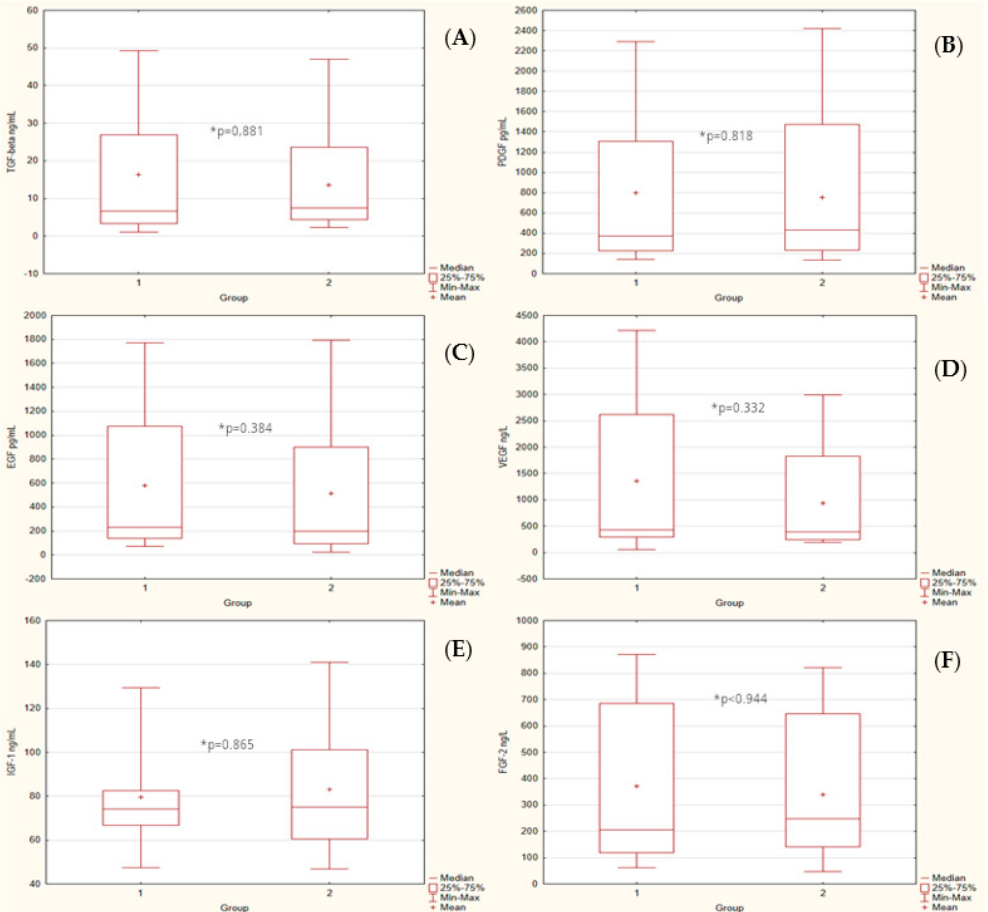
Figure 2. Concentration of markers of control (1) and study group (2). ( A ) TGF- β , U = 292, * p = 0.881; ( B ) PDGF, U = 288, * p = 0.818; ( C ) EGF, U = 256, * p = 0.384; ( D ) VEGF, U = 251, * p = 0.332; ( E ) IGF-1, U = 291, * p = 0.865; and ( F ) FGF-2, U = 296, * p < 0.944.